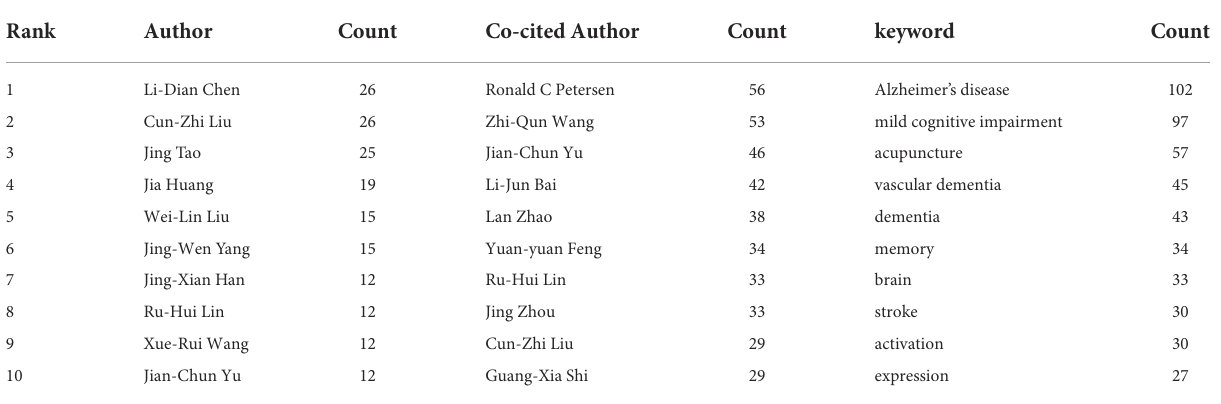
TABLE 4 The top 10 authors, co-cited authors, and